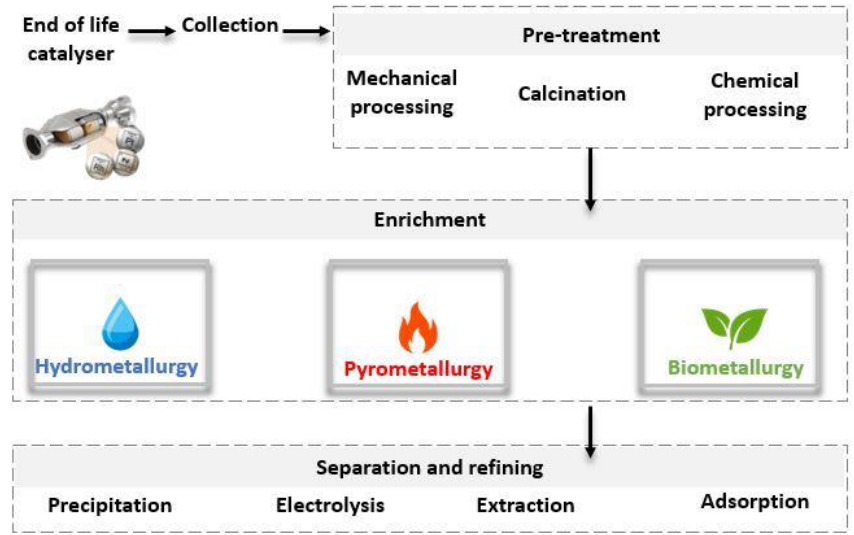
Figure 9. PGMs recycling scheme.